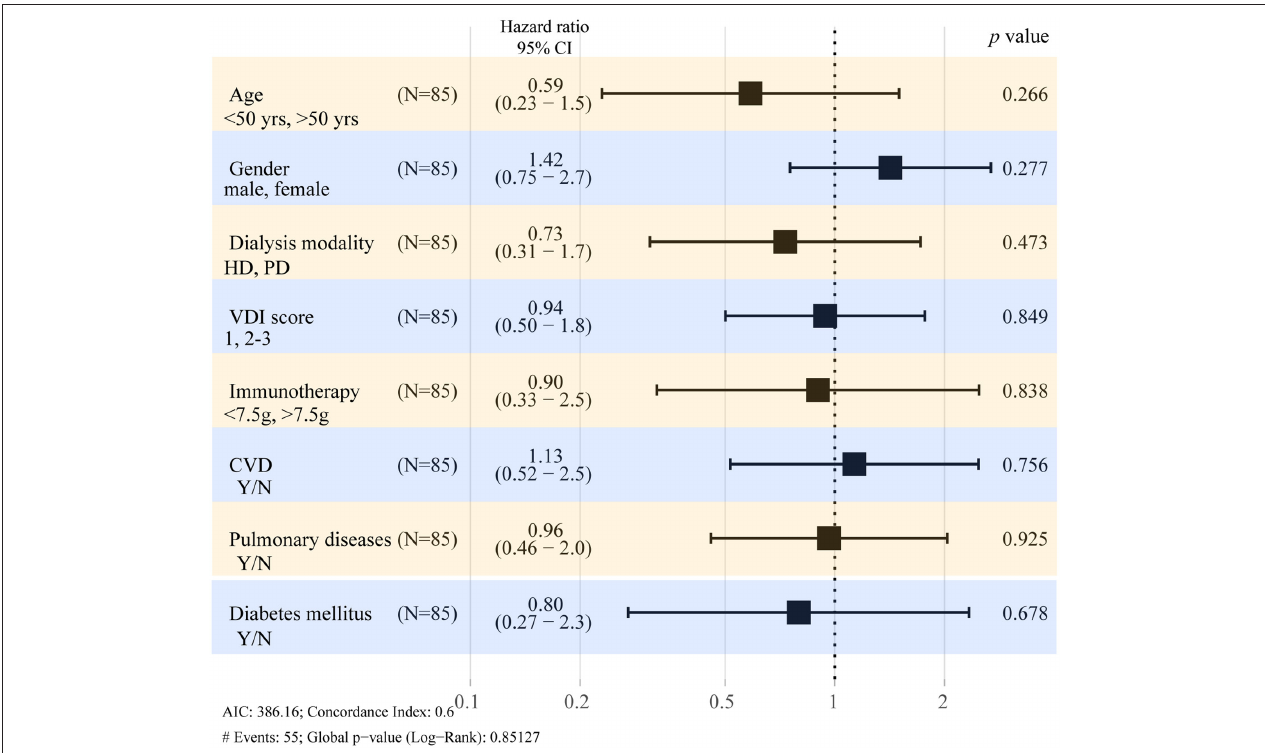
FIGURE 2 | Hazard ratios for death in AAV-ESRD patient with long-term dialysis. Forest plots show the results of multivariate analysis of predictors at dialysis initiation. CI, confidence interval; HD, hemodialysis; PD, peritoneal dialysis; VDI, Vasculitis Damage Index; CVD, cardiovascular disease.